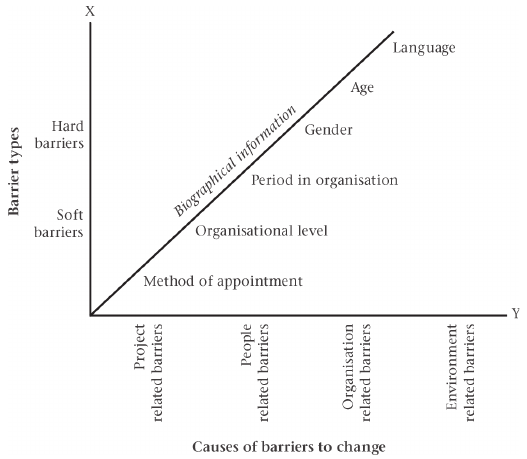
Figure 1: Barriers-to-Change